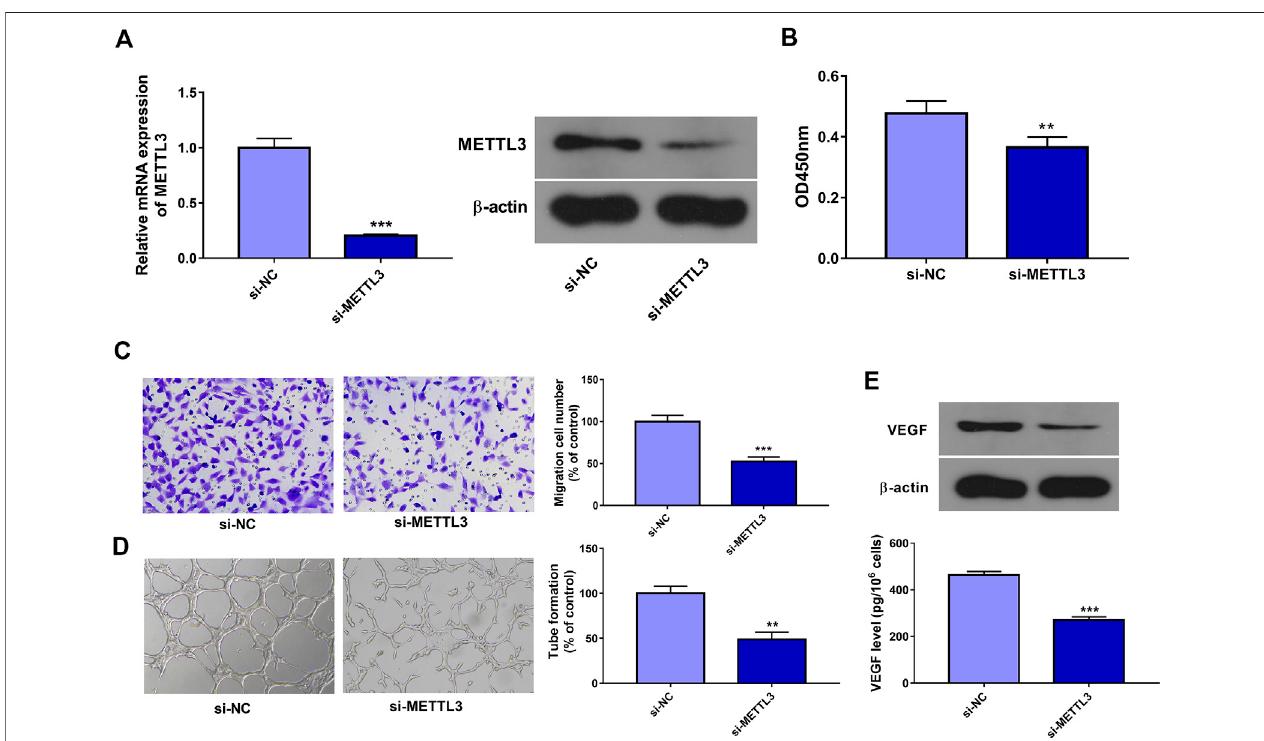
FIGURE 2 | METTL3 knockdown inhibited cell proliferation, migration, tube formation, and VEGF expression/secretion in ox-LDL-treated HUVECs. (A) HUVECs were transfected with si-NC or si-METTL3. Forty-eight hours later, METTL3 mRNA and protein levels were measured through RT-qPCR and western blot assays, respectively. (B – E) HUVECs transfected with si-NC or si-METTL3 were stimulated with 10 μ g/ml of ox-LDL. (B, C) At 24 h after ox-LDL treatment, cell proliferative (B) andmigratory (C) abilitiesweremeasuredthroughCCK-8andTranswellmigrationassays,respectively. (D) At12 hafterox-LDLexposure,tubeformationcapacity wasassessed by tube formation assay. (E) VEGF protein expression and secretion levels were determined through western blot and ELISA assays at 24 h after ox-LDL treatment, respectively. Three independent experiments were performed for all in vitro assays. ** p < 0.01, *** p < 0.001.